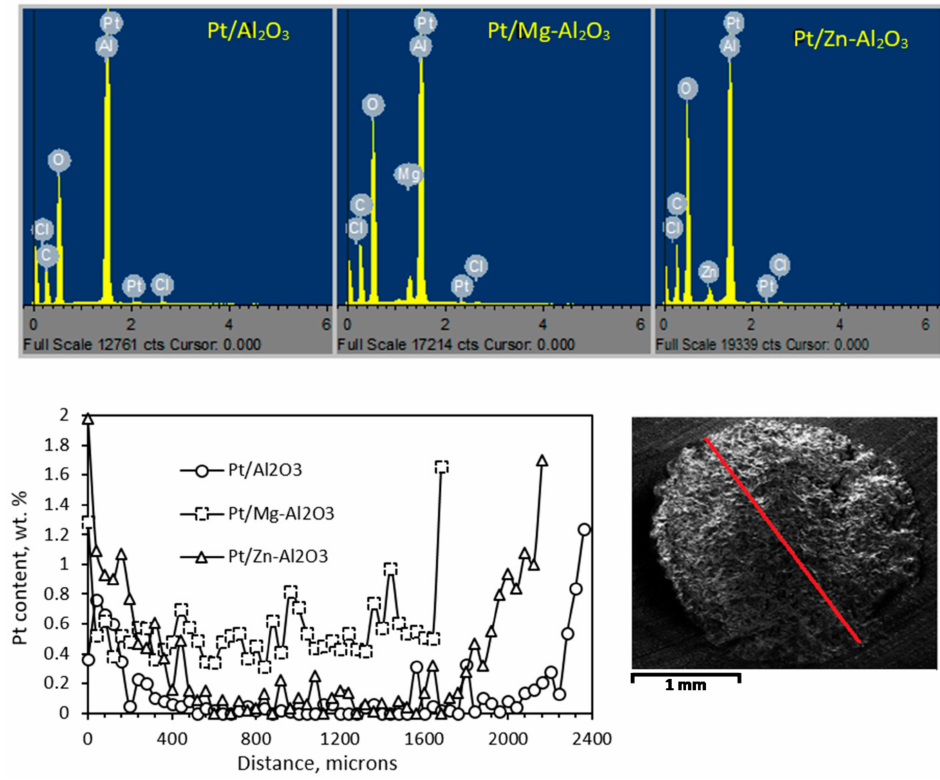
Figure 6. Elemental line scan analysis showing Pt distribution at 40-micron